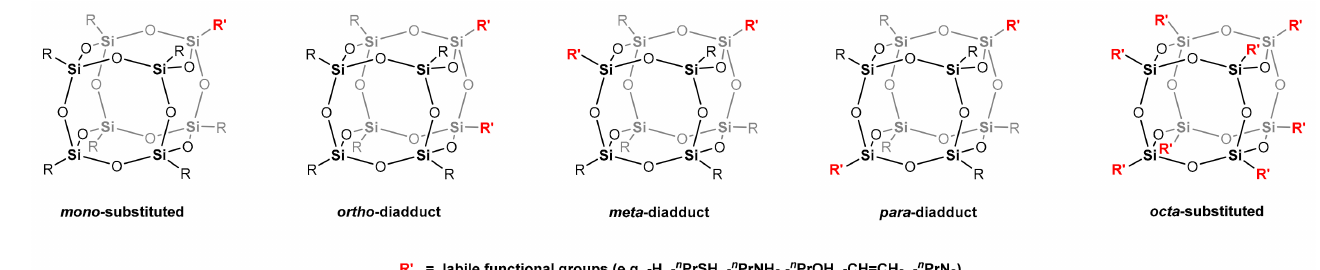
Figure 2. Types of T 8 -type polyhedral oligomeric silsesquioxanes.